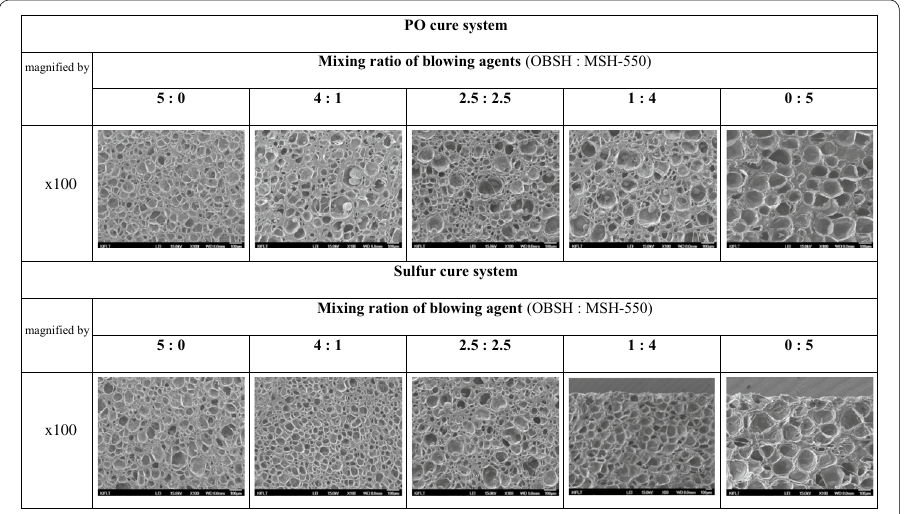
Fig. 3 SEM images of bio‑EPDM foam depending on the mixing ratio of blowing